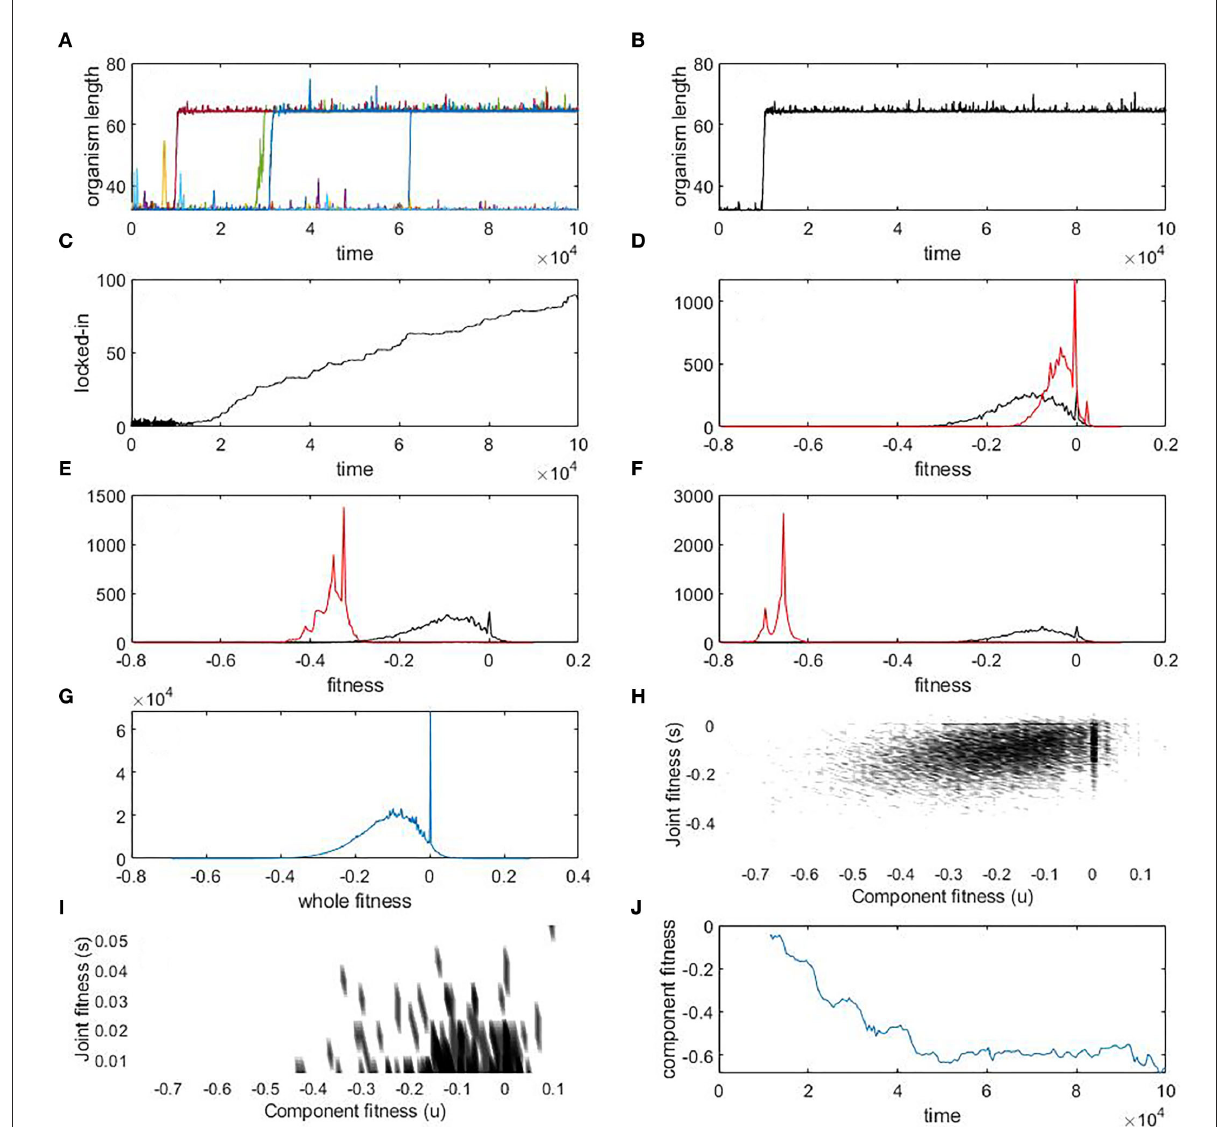
FIGURE3 Results from NK simulations. (A) Time series of organism length for eight simulations. (B–J) Results from a single simulation where locking-in of a joining mutation happens early on. See text for more details. For panels (D–G) , the y-axis represents the frequency of the distributions. See text for more